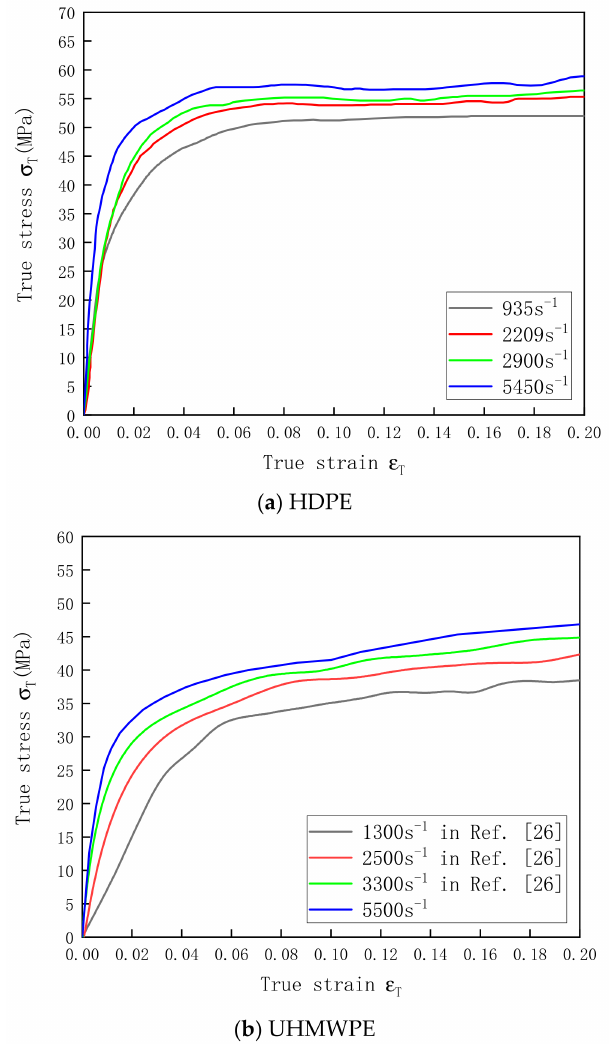
Figure 7. Stress–strain curves of ( a ) HDPE and ( b ) UHMWPE at a temperature of 25 ◦ C under dynamic